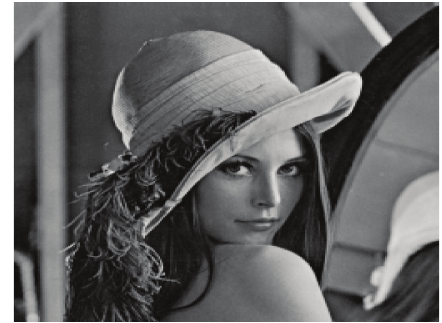
Figure 9: Test image “lena.”